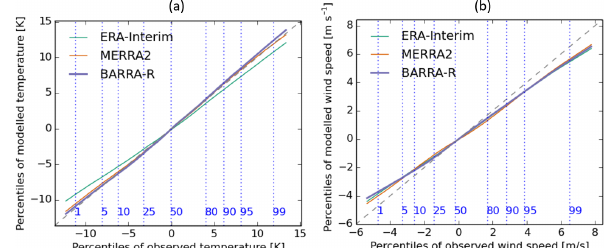
Figure 4. Comparisons of percentile values between observations and reanalyses for (a) 2m temperature, and (b) 10m wind speed during 2010–2013. The values for percentiles 0.05 to 99.95 are cal- culated using values derived from monthly means. The vertical blue dashed lines indicate the corresponding percentiles of the observa-